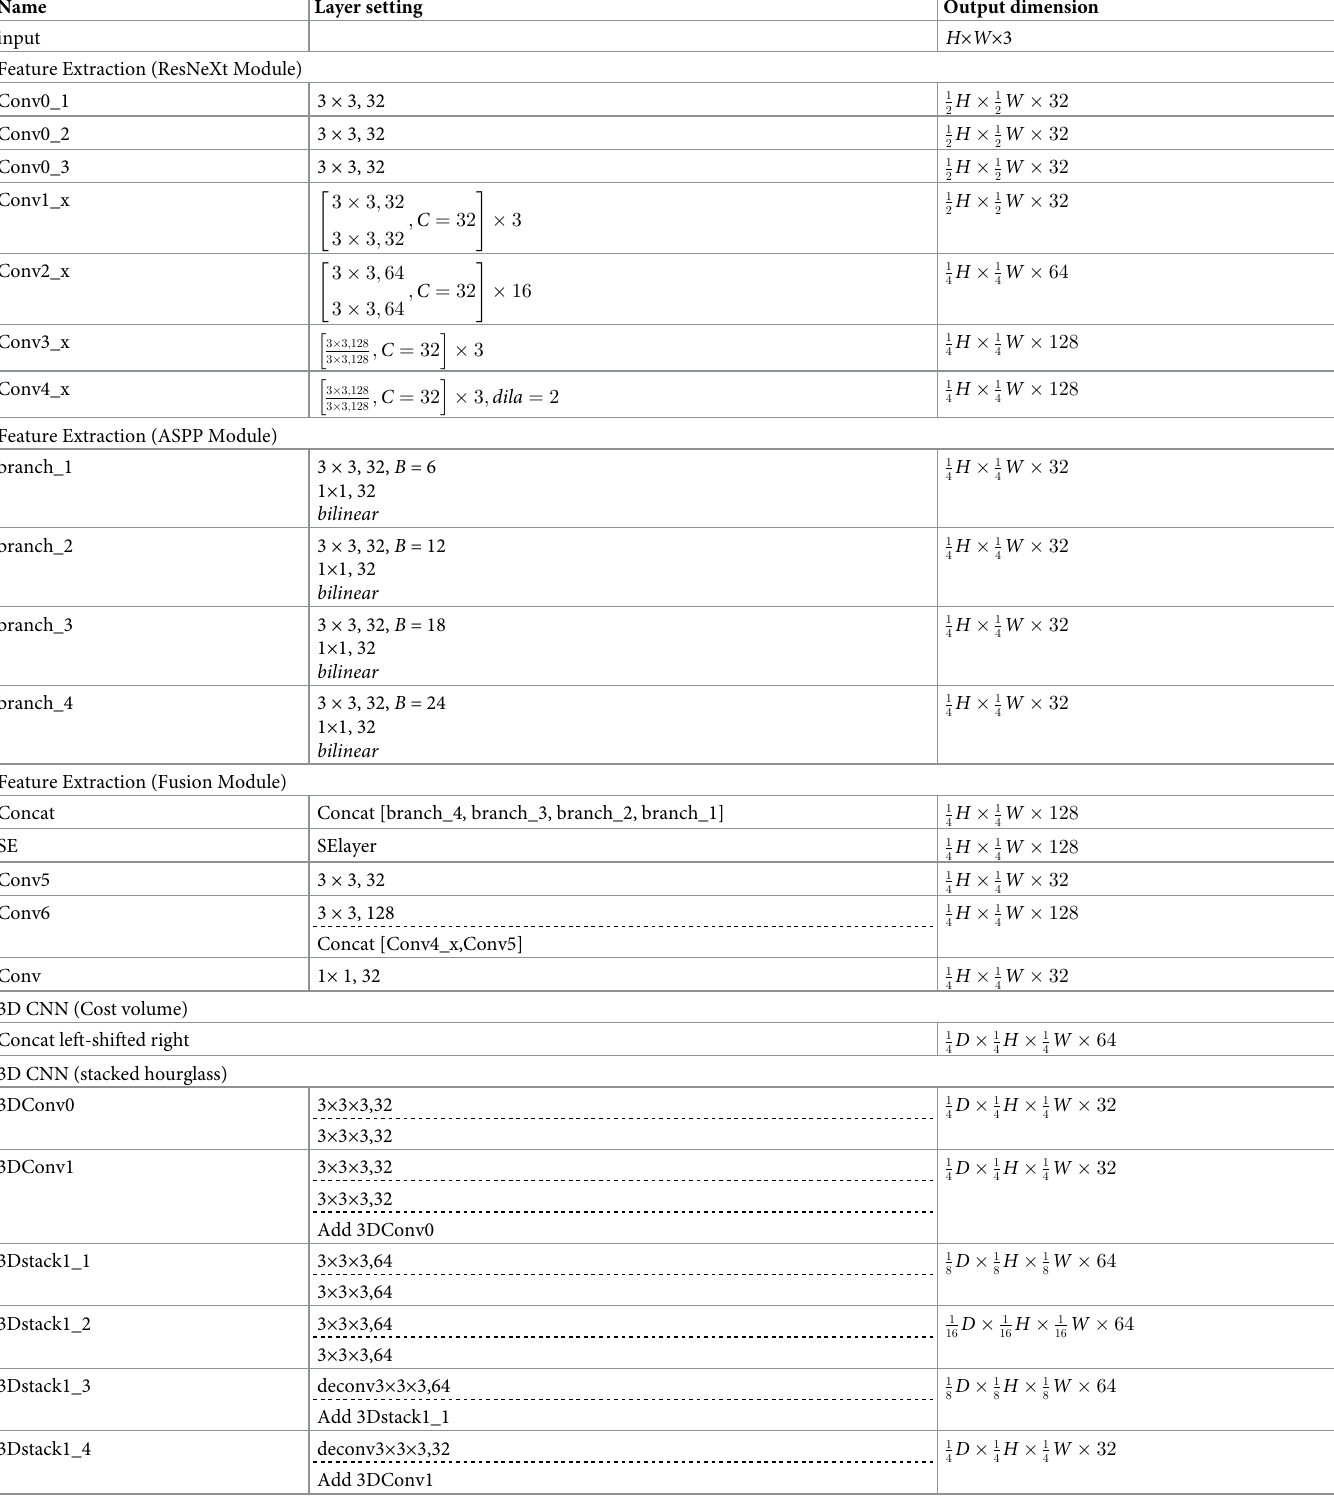
Table 1. Parameters of the improved PSMNet